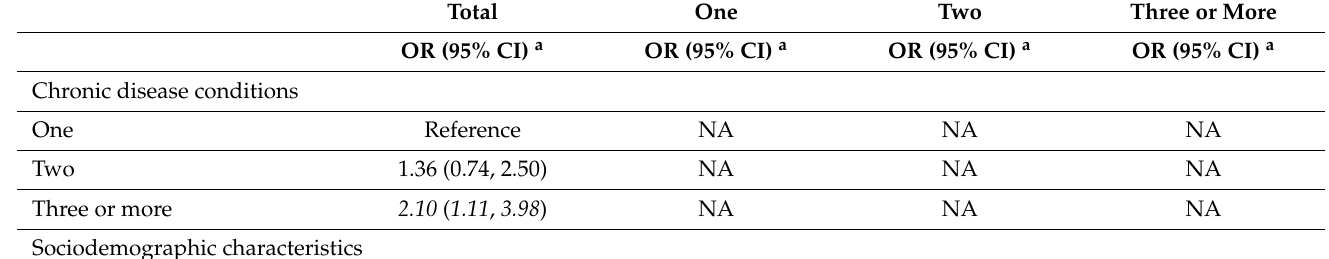
Table 2 examines the association between the presence of chronic diseases and CRC screening use, adjusted for sociodemographic characteristics, quality of life, and cancer- related factors. In our full model, survivors with multi-morbidities (OR, 2.10; 95% CI,